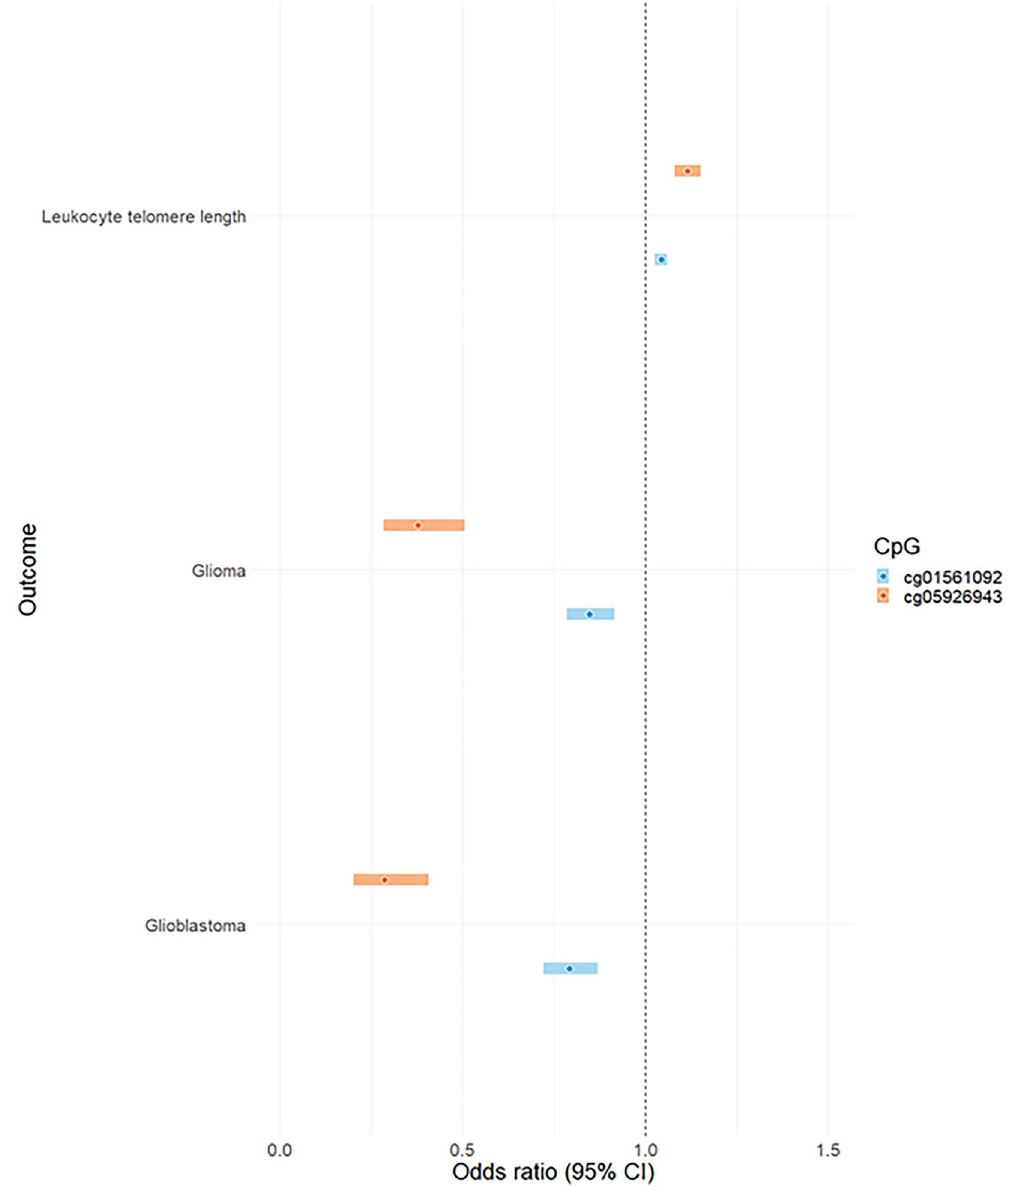
Figure 3. The MR estimates of CpG methylation on glioma, glioblastoma and telomere length. The association between that associated with glioma, glioblastoma and telomere length; OR (95%) is the effect of DNAm on glioma, glioblastoma and telomere length. MR effect estimates are reported as odds ratios (95% confidence intervals (CI)) per 1 standard deviation change in genetically proxied